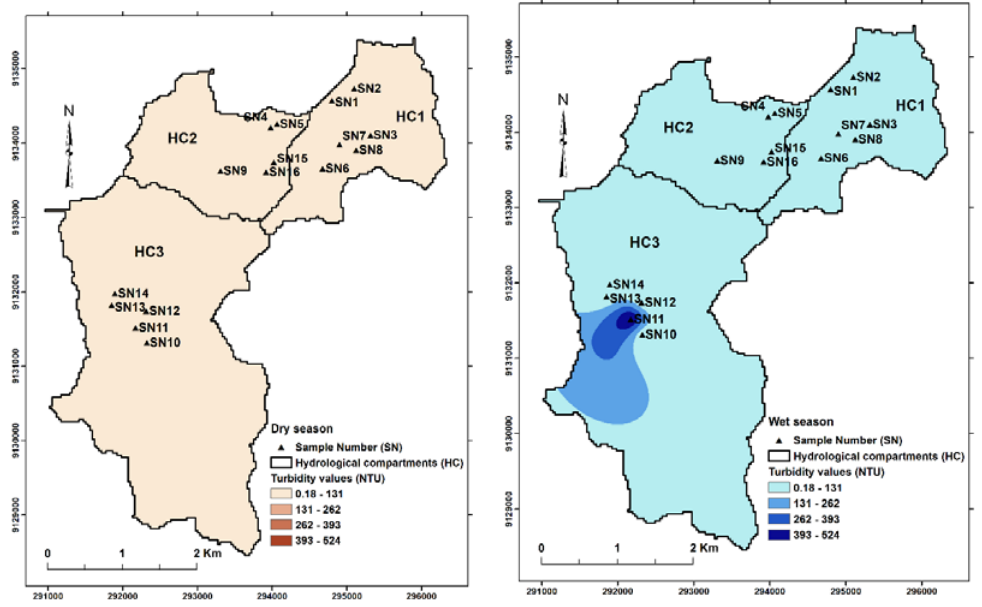
Figure 3. Spatial distribution of turbidity in the dry and wet seasons in the three hydrological